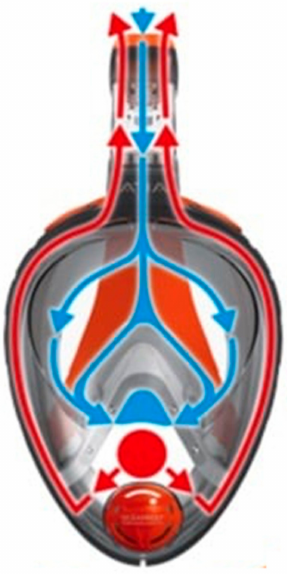
Figure 5. Schematics of air flow in snorkel masks. Blue—inspiration flow, red—expiratory flow. Simultaneously, fingertip saturation of oxygen (SaO 2 ), heart rate (HR), and transcutaneous CO 2 (PTcCO 2 ) and oxygen (PTcO 2 ) levels were measured (HMMS Medical Monitoring System, Haux GmbH, Karlsbad,